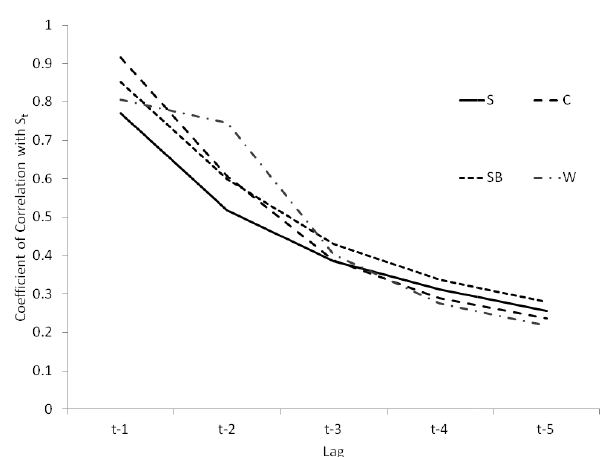
Lag analysis for the four gauging stations.